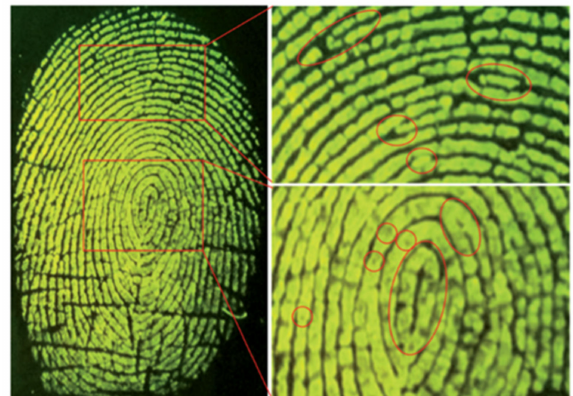
Figure 22. Fluorescence image of fingerprint on a PVDF membrane with a bandpass filter [66].